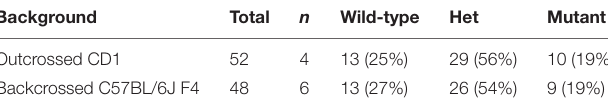
TABLE 1A | Number of wild-type, C2cd3 ex2 / + , and C2cd3 ex2 / ex2 embryos on CD1 and C57BL/6J backgrounds.